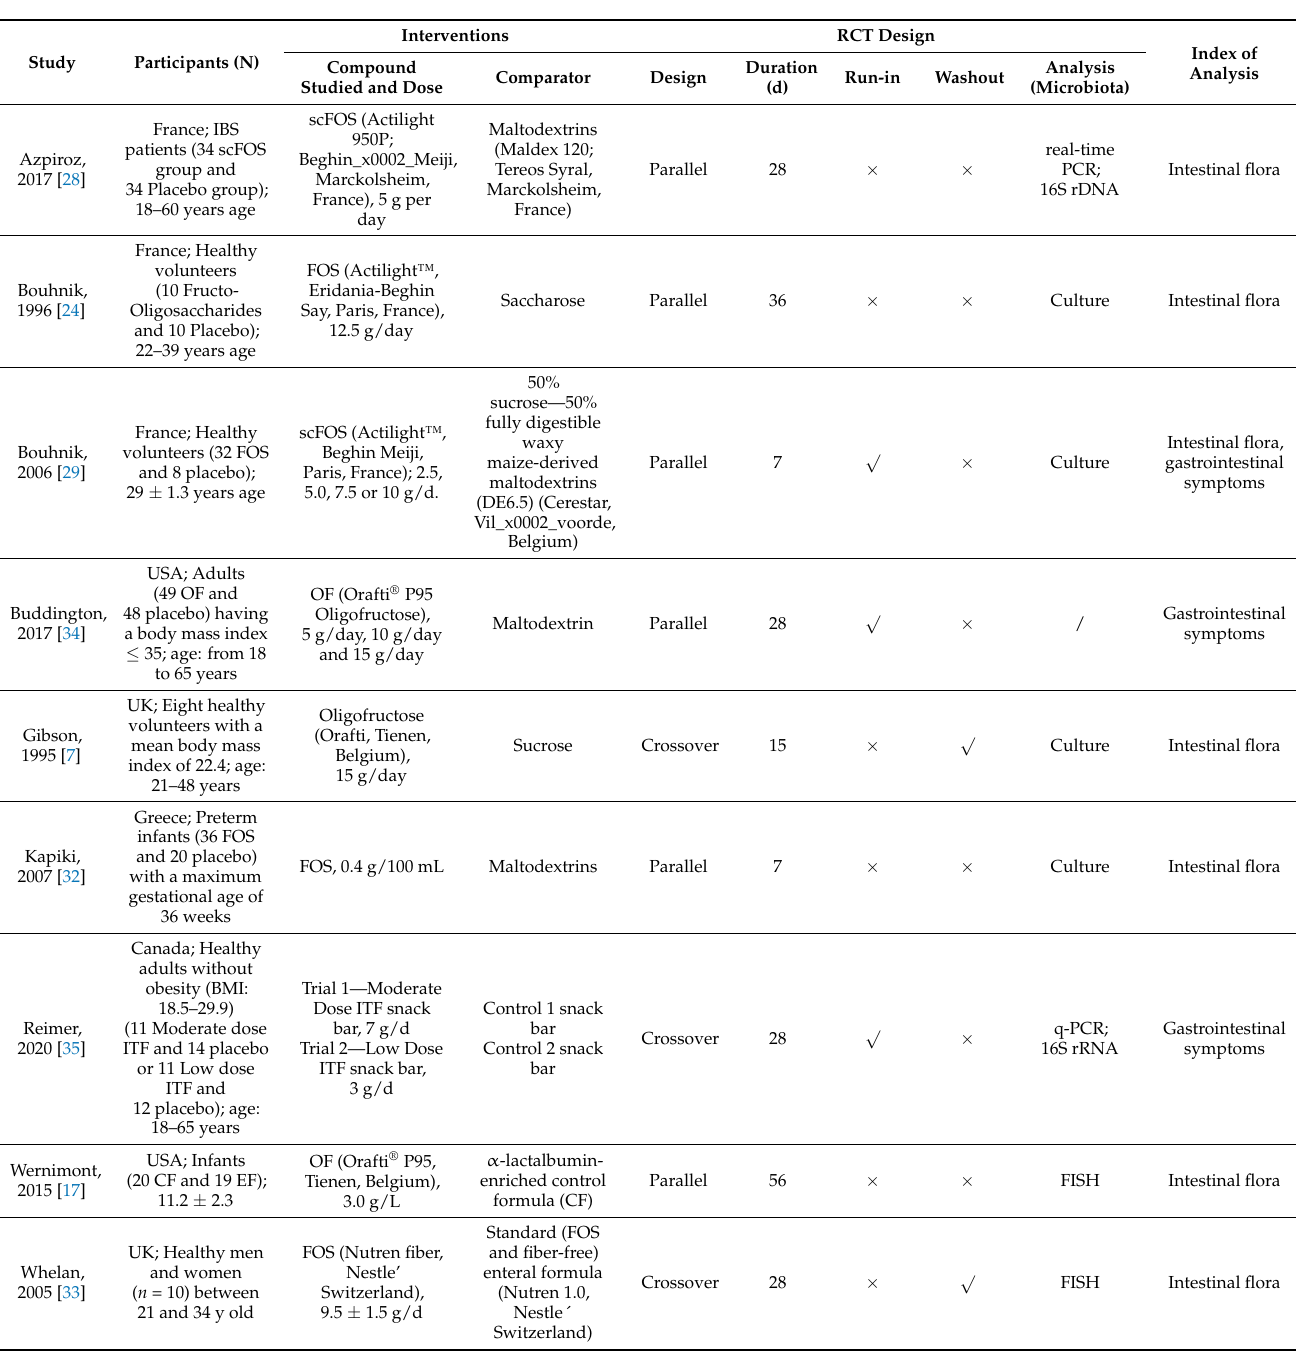
Table 1. Description of included